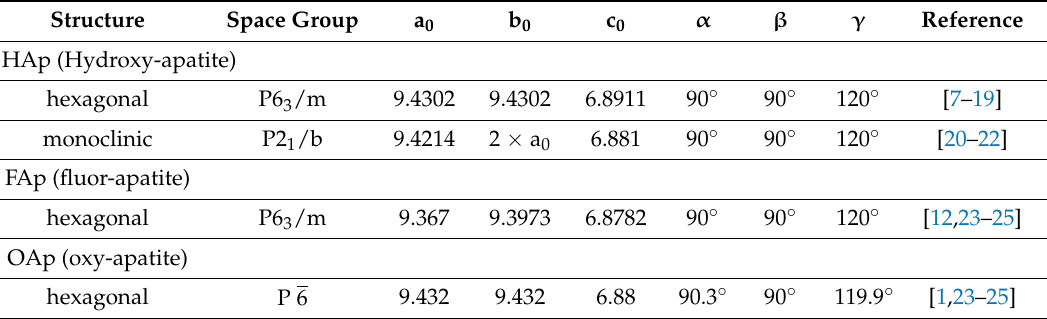
Table 2. The main minerals of the Apatite group, along with their lattice parameters (in Å) and Space Groups, as it comes out from